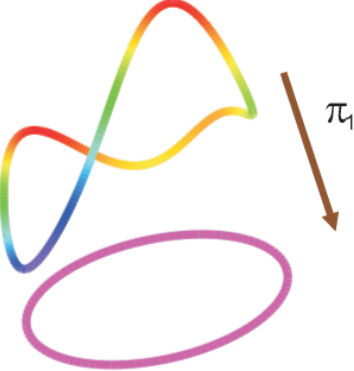
Figure 1. The curve defined by the ideal in Eq. (2) projects to the unit